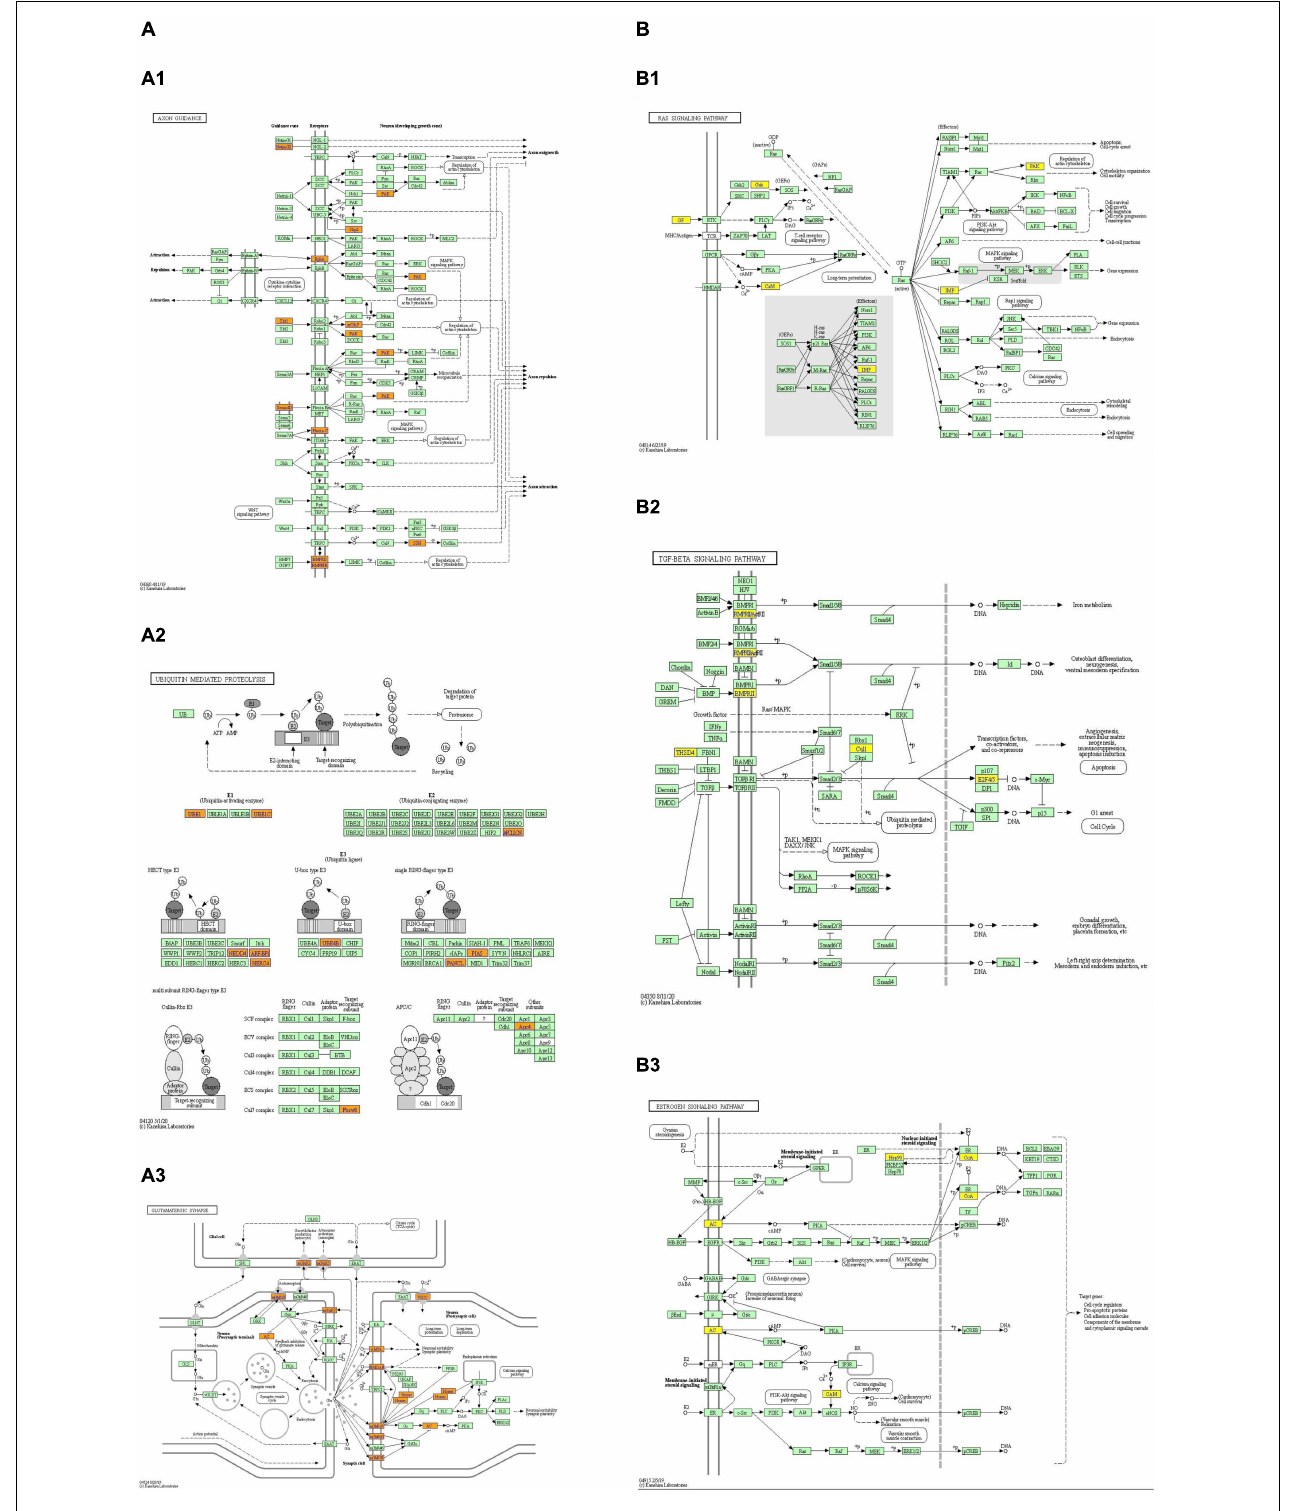
FIGURE 5 | The top 3 upregulated and downregulated (A,B) KEGG pathway map. Orange marked nodes are associated with up-regulated or only whole dataset genes, yellow marked nodes are associated with down-regulated genes, green nodes have no significance. Up-regulated pathways: (A1) axon guidance; (A2) ubiquitin mediated proteolysis; (A3) glutamatergic synapses. Down-regulated pathways: (B1) RAS signal pathway; (B2) TGF- β signal pathway; (B3) estrogen signal pathway.